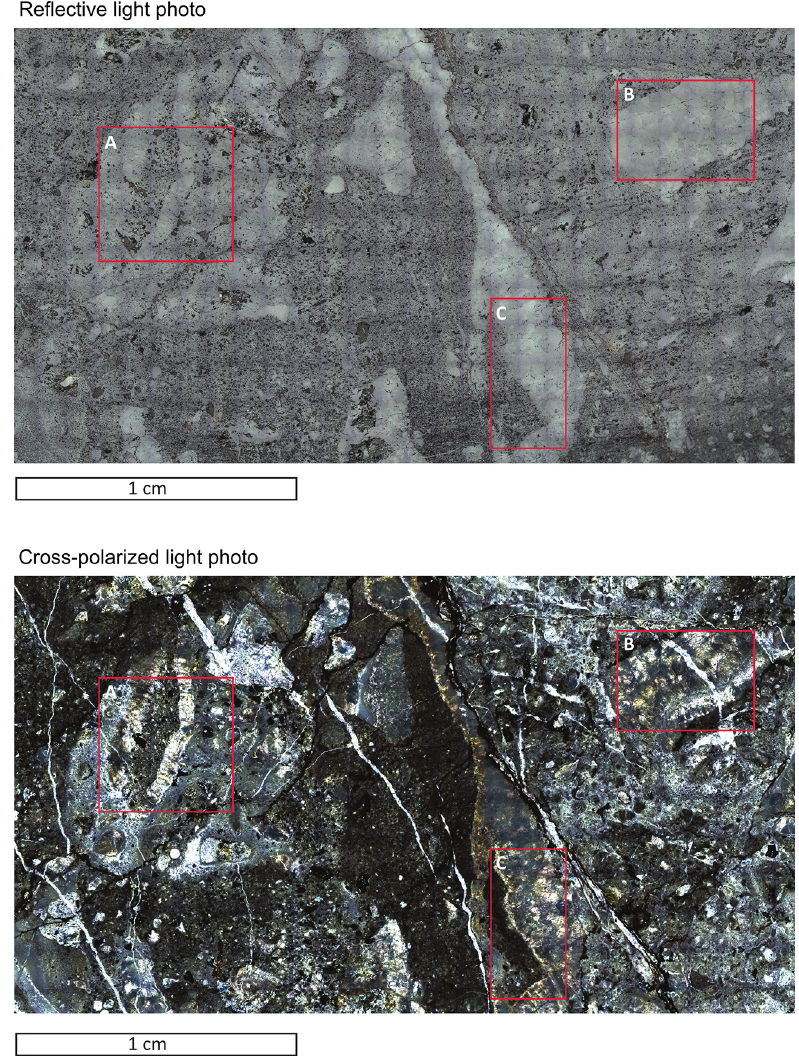
Figure B1. Reflected light image and cross-polarized light image of the investigation area on sample 17NP436a.